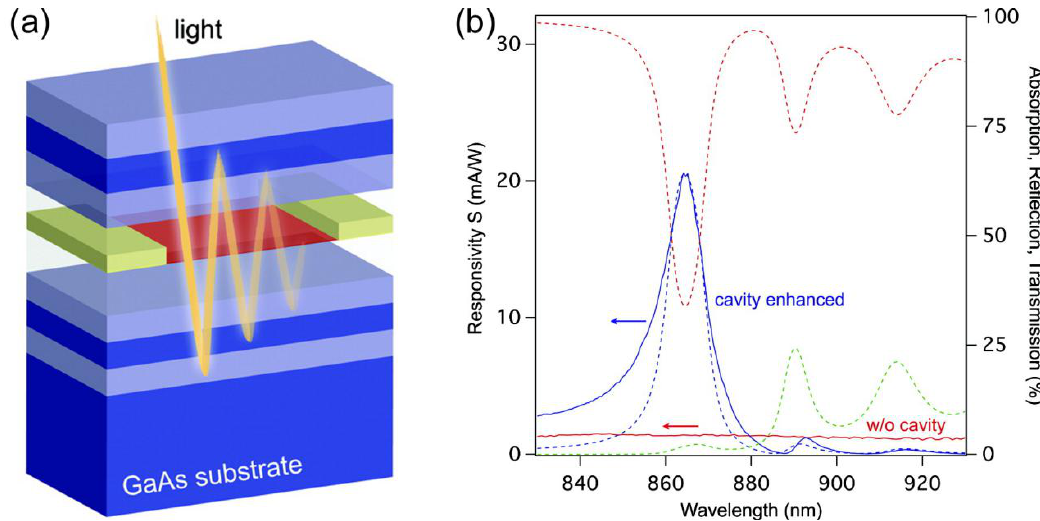
Figure 8. ( a ) Schematic drawing of the graphene microcavity photodetector. Distributed Bragg mirrors form a high finesse optical cavity. ( b ) Spectral response of the bilayer graphene device. The dashed lines show calculation results: reflection R (red), transmission T (green), and absorption A (blue). The solid lines are measurement results: photoresponse for the device with cavity (blue) and photoresponse for the device without cavity (red). Reproduced from reference [45], with permission from American Chemical Society,